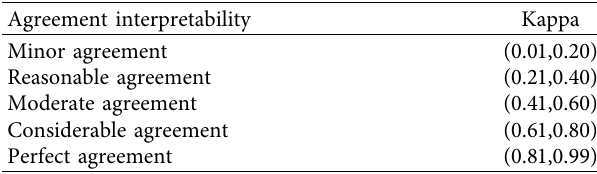
Table 4: Kappa score